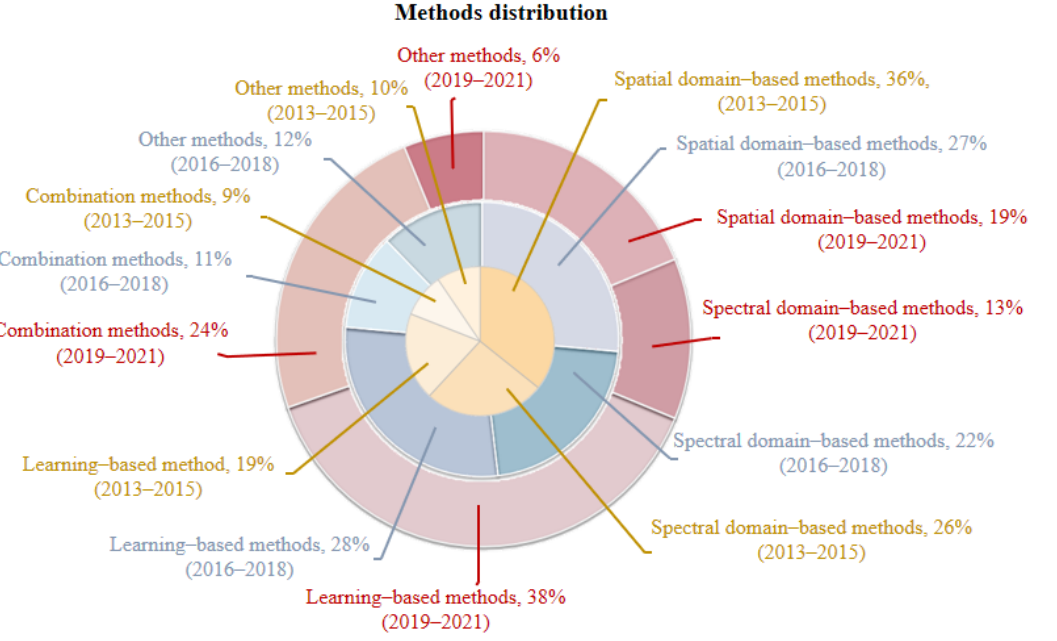
Table 3. Specific information of different methods for comparison.